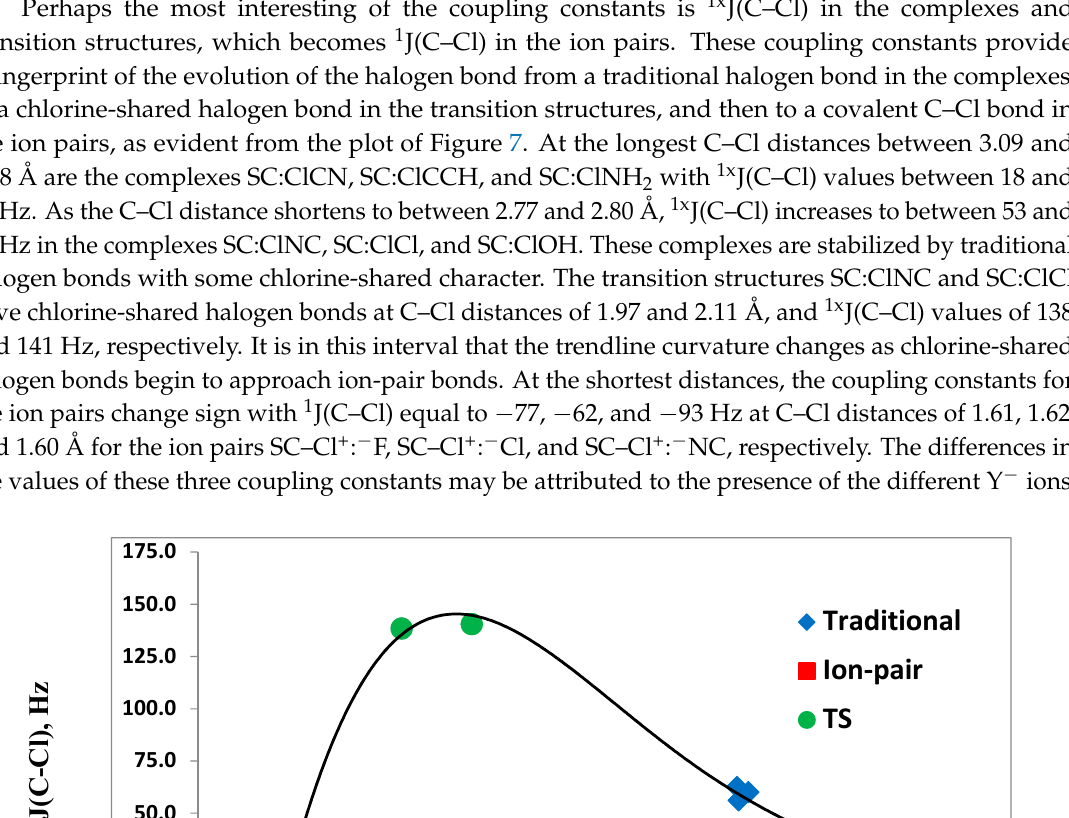
Figure 8. 1 J(S–C) versus the S–C distance for SC:ClY complexes, transition structures, and ion pairs, and the CS monomer.